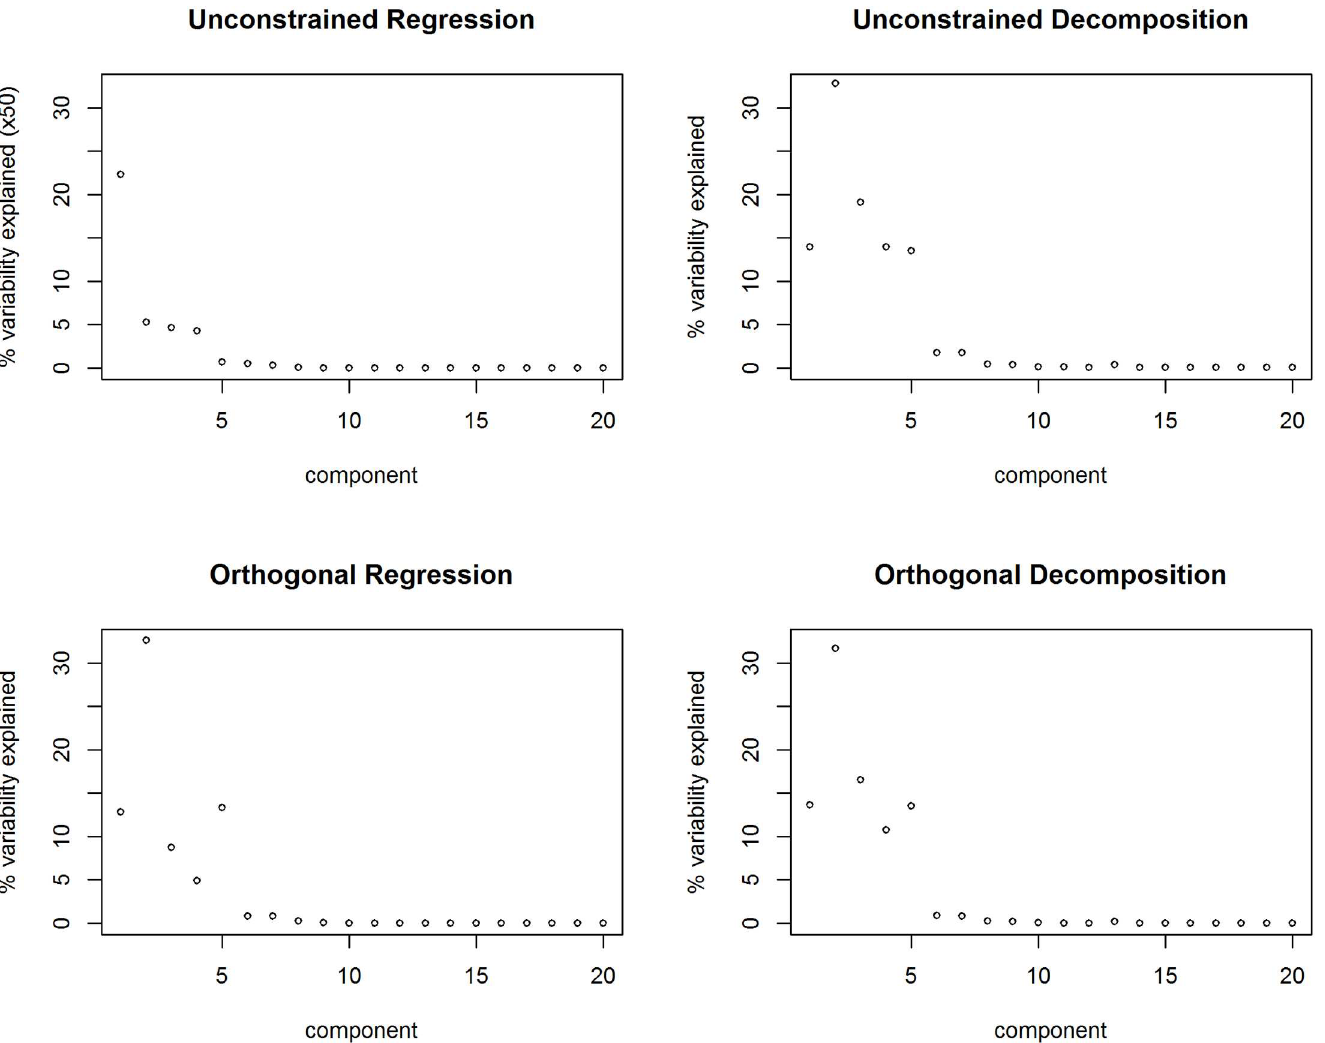
Fig 1. Screeplots for varianceexplained by each component. For each method, the contributionof the first 20 (of 44) componentsplotted. Note the changeof scale for unconstrained regression.Components are orderedby decreasing eigenvalueof the Unifrac